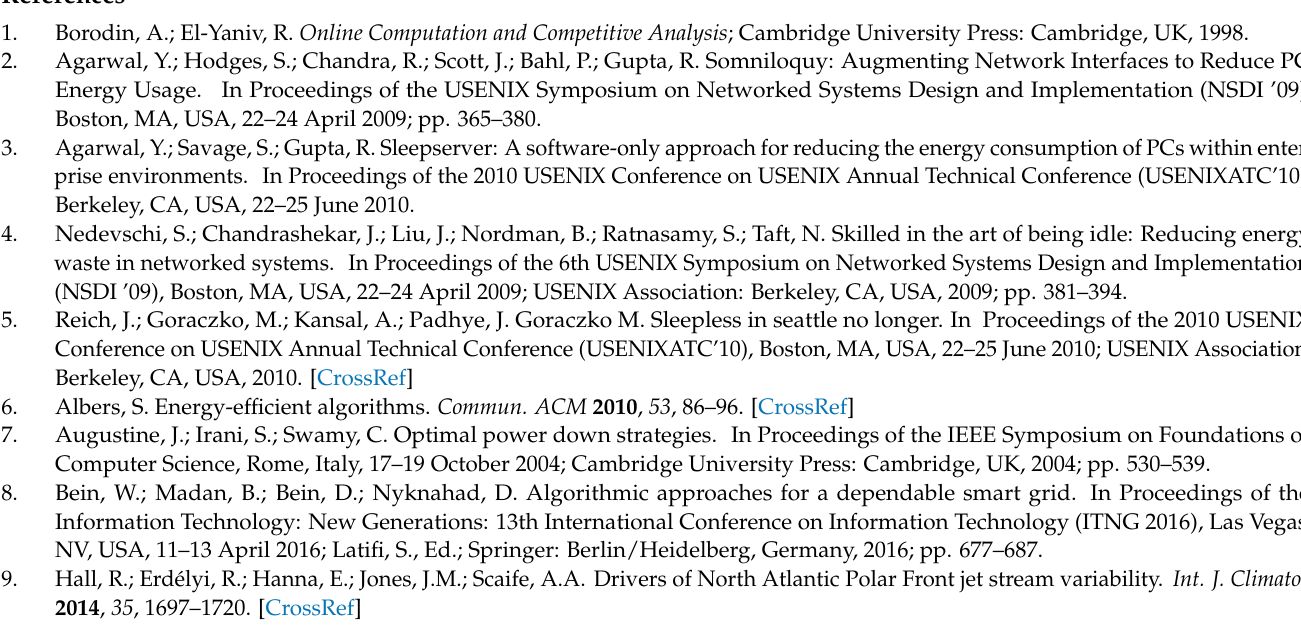
Figure A2. Simulations exponential strategies for various parameter